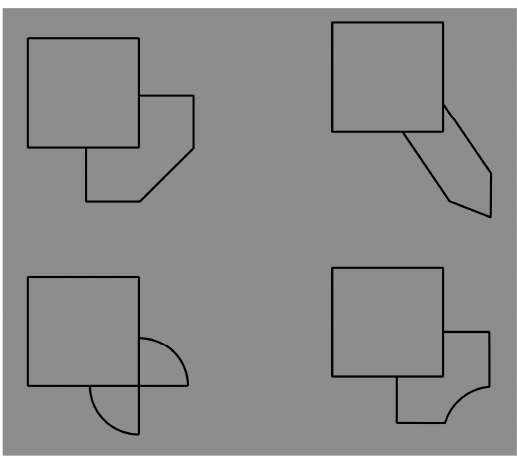
Figure 21. A control for Figure 20. The figures, partially occluded by the square, complete amodally as asymmetrical shapes.